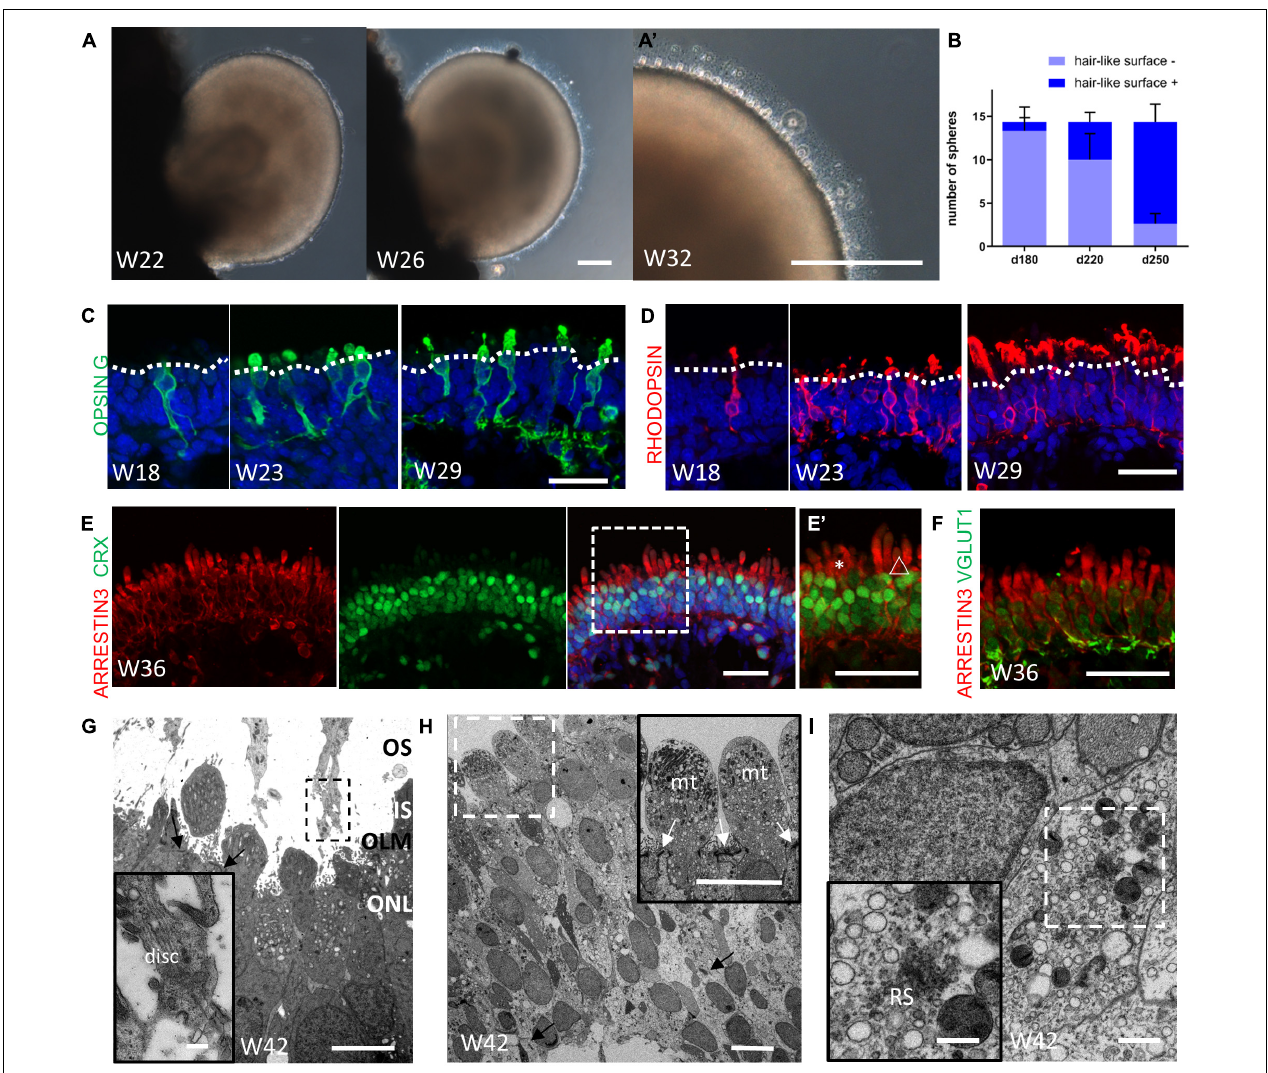
FIGURE 5 | Maturation of photoreceptor cells in retinal organoids. (A) Representative images showing the onset of hair-like microvilli on the surface of the retinal organoid at Week 22, Week 26, and (A’) Week 32. Scale bar = 100 µ m. (B) Progressive increase in the number of retinal organoids with hair-like microvilli ( n = 3 independent experiments per group; each group contained 18, 12, and 13 retinal organoids, respectively). (C,D) Representative images showing the maturation of cone and rod PRs, as indicated by the mature PRs markers Opsin Green/Red ( C , Opsin G/R, green) and RHODOPSIN ( D , red) at Week 18, Week 23, and Week 29. Scale bar = 50 µ m. (E) Immunofluorescent staining of the PR marker ARRESTIN 3 (red) and CRX (green) showed that a 4/5-nuclei–thick layer was formed. (E’) Higher magnification of (E) showing the distinct morphology of the cone outer segment (asterisks) and the rod outer segment (triangle). Scale bar = 50 µ m. (F) The co-staining of ARRESTIN 3 (red) and vesicular transporter marker VGLUT1 (green) indicated the formation of the PR synapse. Scale bar = 50 µ m. (G) Electron microscopy showed the formation of outer segments-like (OS) and inner segments-like structure (IS), outer limiting membrane (OLM, indicated by black arrow) and outer nuclear layer (ONL). Scale bar = 5 µ m. The insert image showed the infolding disk-like structure in OS. Scale bar = 0.5 µ m. (H) The 4/5-nuclei–thick ONL was shown. The black arrow indicated that the ribbon synapses-like structure were present at basal side of photoreceptors. Scale bar = 10 µ m. The insert image showed the mitochondria-rich inner segment-like structure. The white arrow indicated the OLM. Scale bar = 2 µ m. (I) The clearer image of ribbon synapse-like structure (RS) was shown, surrounded by various vesicles. Scale bar = 500 nm (The insert image scale bar = 50